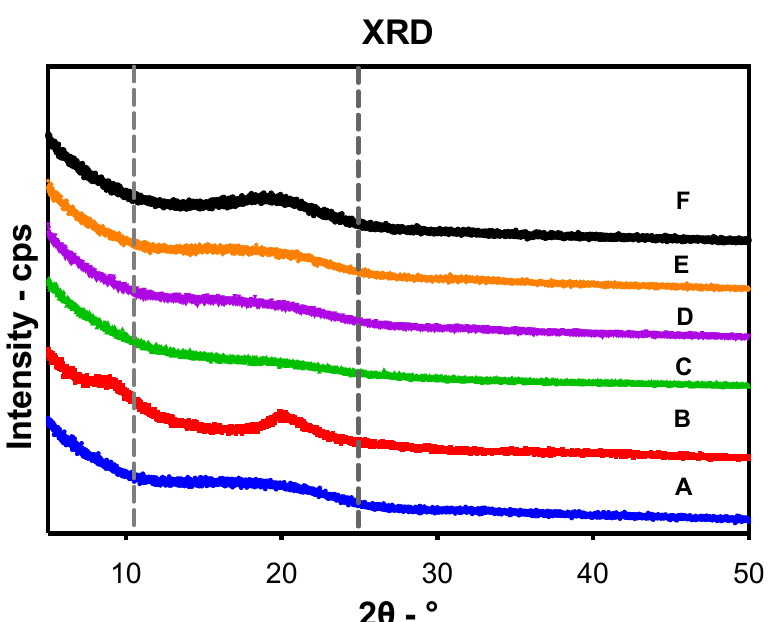
Figure 7. Powder X-ray diffractograms of ( A ) PLGA, ( B ) chitosan, ( C ) uncoated PLGA particles, ( D ) uncoated PLGA particles loaded with combined oils, ( E ) CS-PLGA particles, and ( F ) CS-PLGA particles loaded with combined EO components.